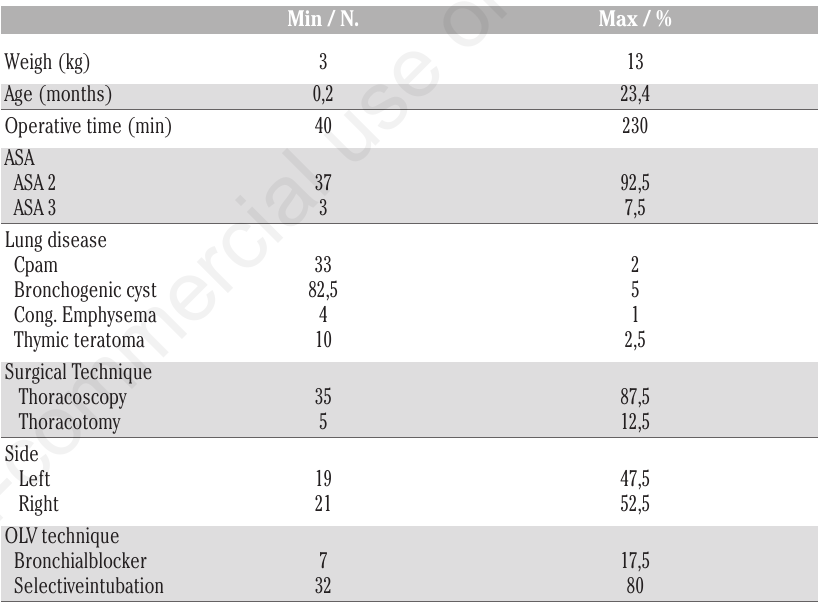
Table 1. Patient characteristics and surgery.